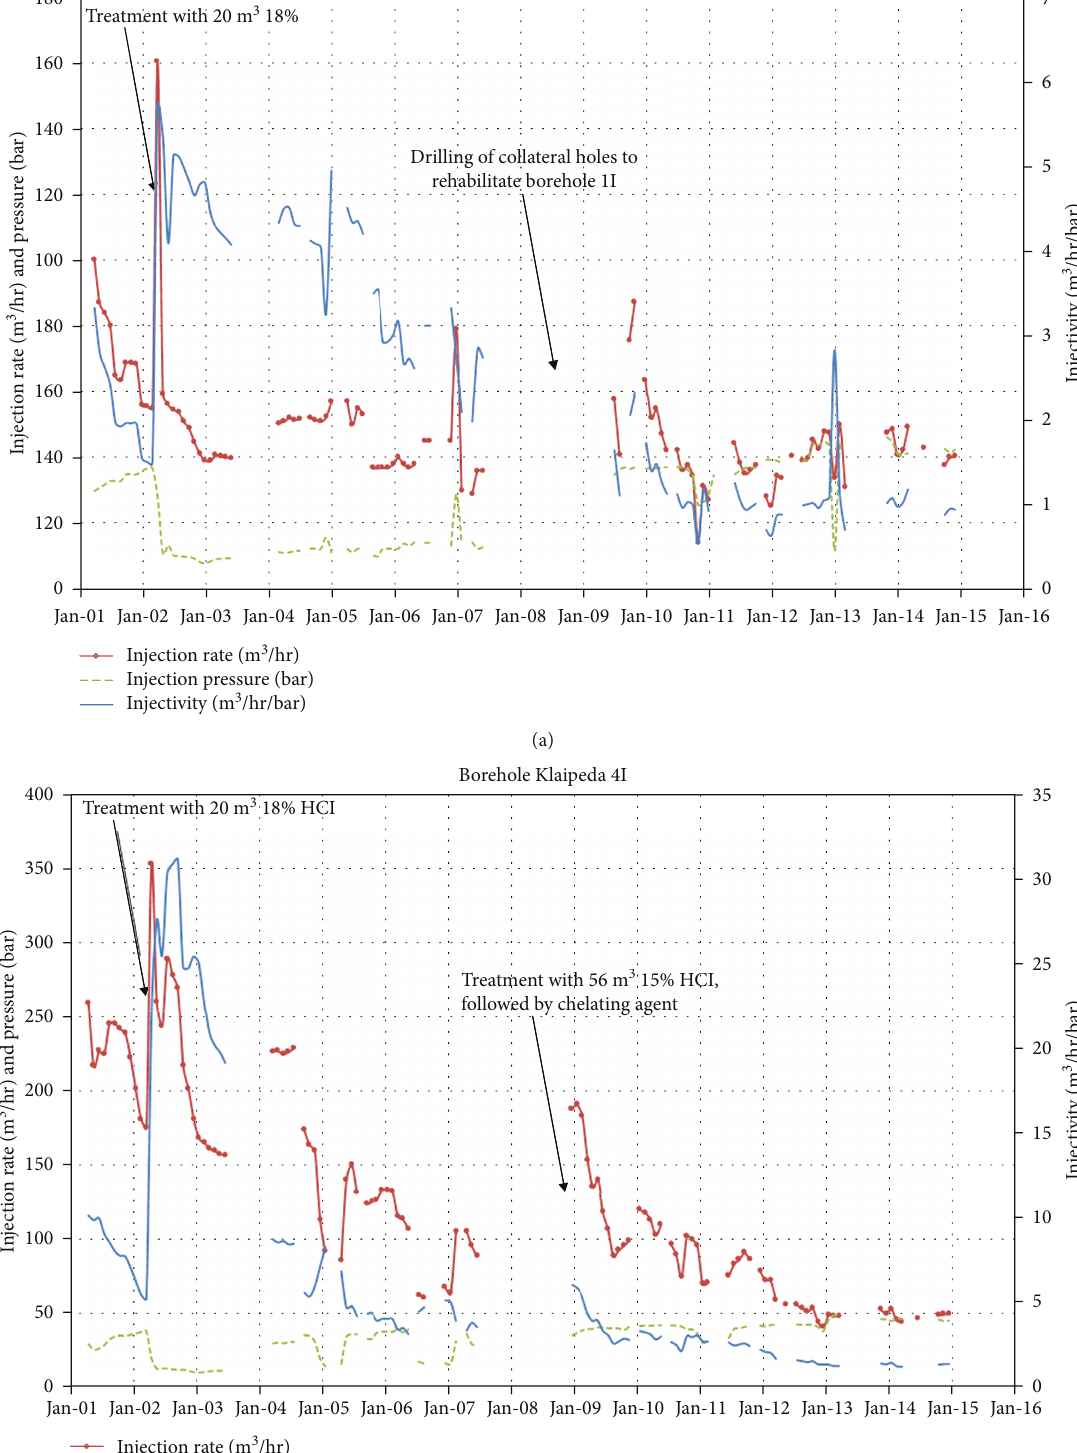
Figure 3: The decline in injectivity with time in boreholes 1I and 4I, showing timing of the most successful rehabilitation works (other works were attempted, with little visible bene fi t). A more detailed description of trialled remediation works can be found in [9,